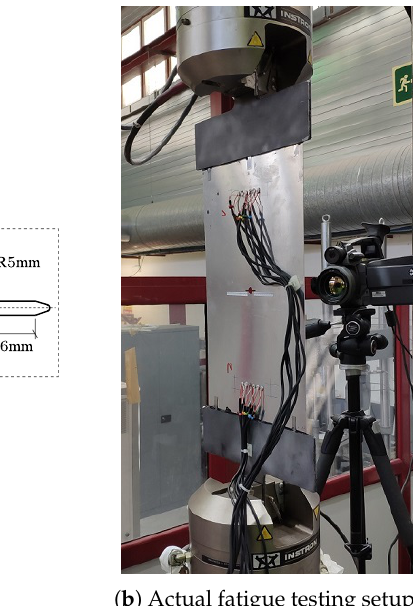
Figure 3. Panel ( a ): Schematic of the specimen and notch geometry, along with the position of the piezoelectric wafer active sensors (PWAS) arrays. Panel ( b ): Picture of M(T) aluminum specimen with two permanently attached phased-arrays mounted on the fatigue testing